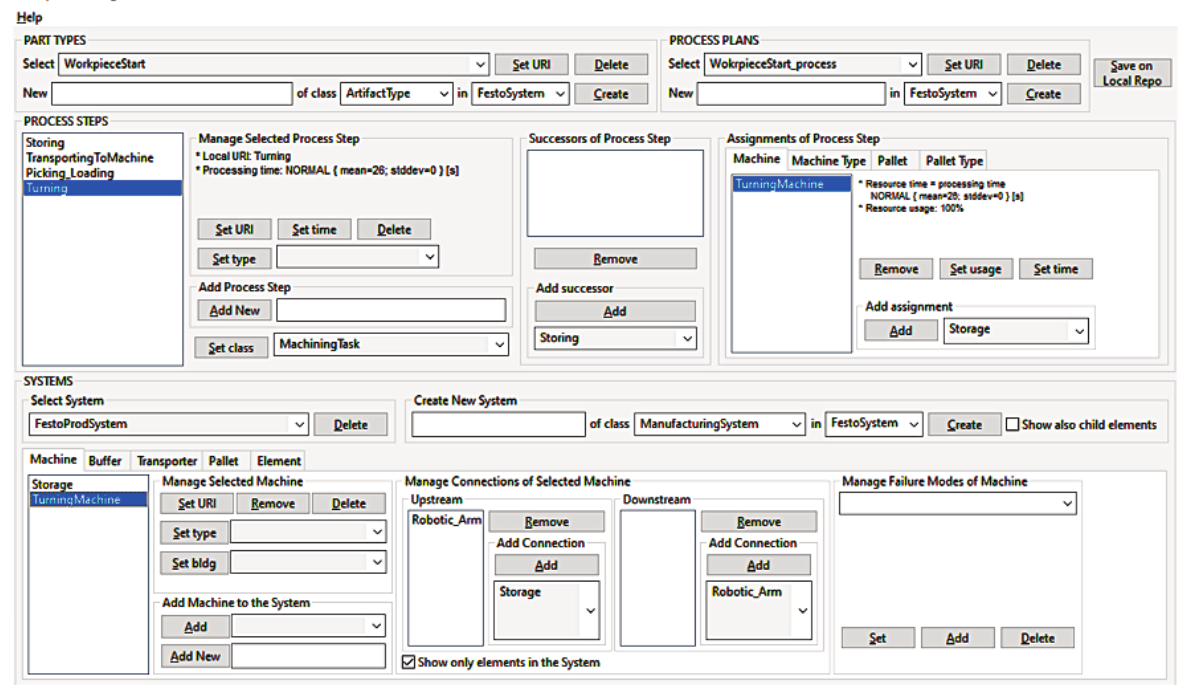
Fig. 6. Use cases’ description via